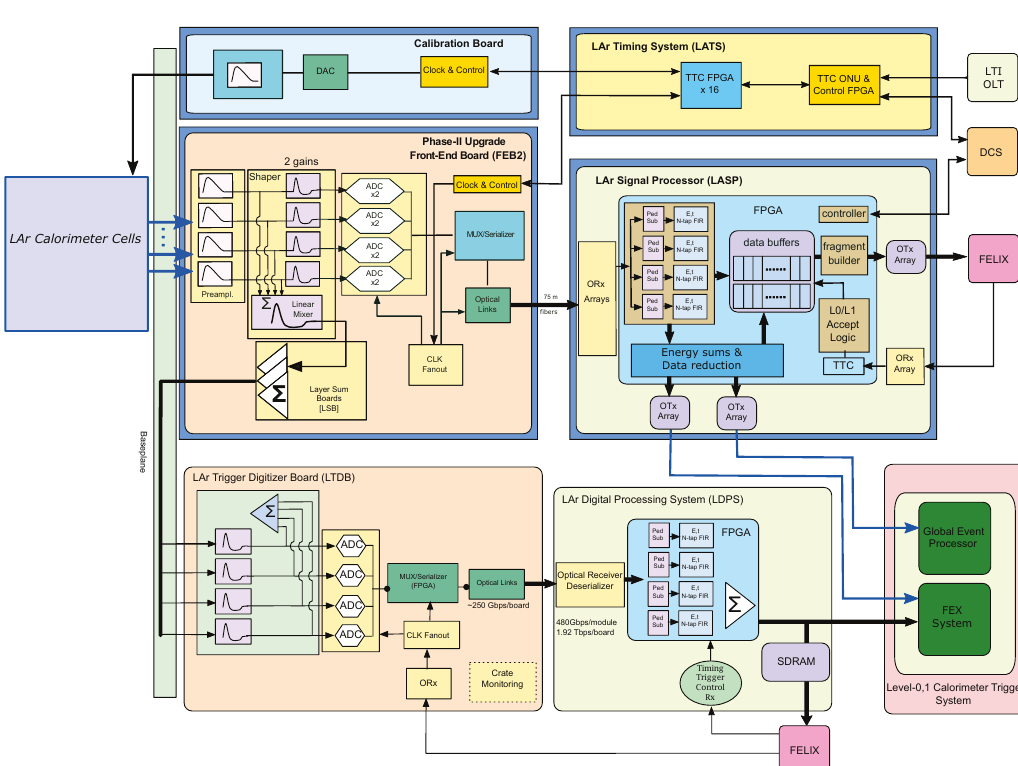
Figure 1: Schematic overview of the LAr calorimeter readout architecture for the Figure 2.1: Schematic block diagram of the LAr calorimeter readout architecture for the Phase II upgrade. The LAr Trigger Digitizer Board (LTDB) and LAr Digital Processing System (LDPS) will have been installed in Phase-II upgrade. The LAr Trigger Digitizer Board (LTDB) and LAr Digital Processing the Phase I upgrade. System (LDPS) are part of the Phase-I upgrade and will remain for